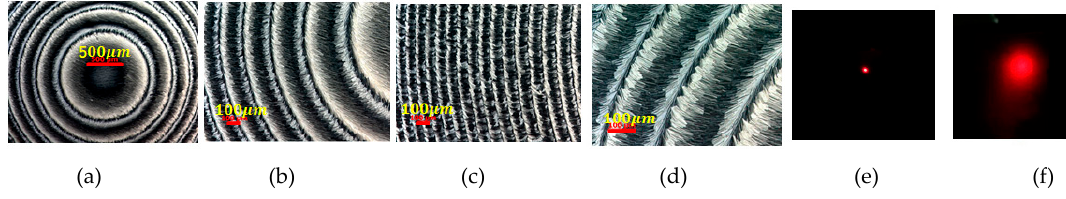
Figure 10. Microphotographs of the PBL structure ( a ) – ( d ) and switchable DHFLC-PBL, which behaves as ( e ) the convex lens and ( f ) the concave lens when the beam light travels through the left (right) hand circular LHC (RHC) polarizer, respectively. The applied voltage is 10 V.